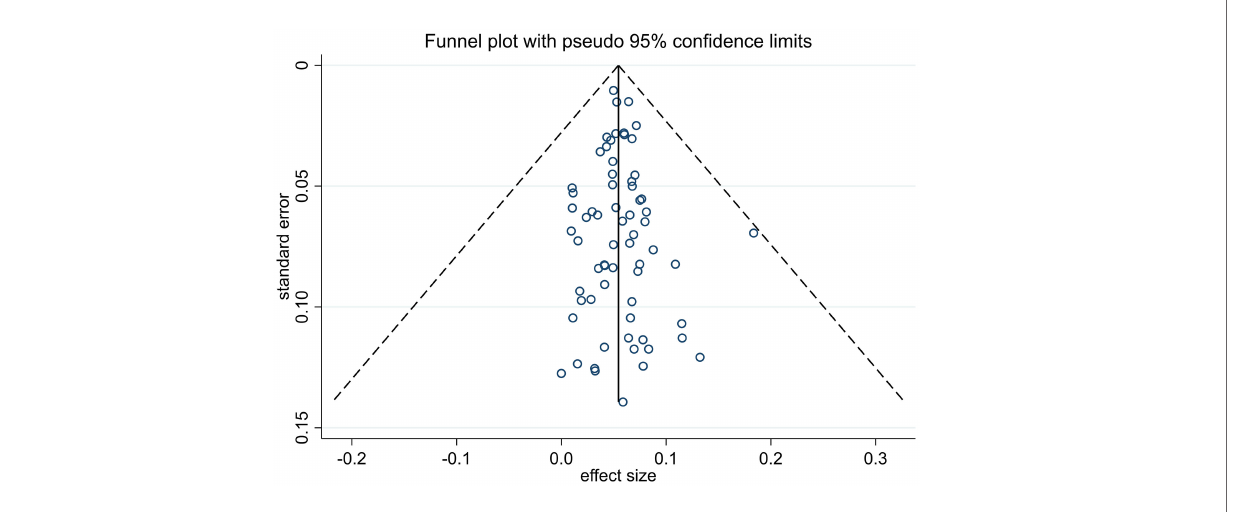
FIGURE 2 | Funnel plot of included studies.